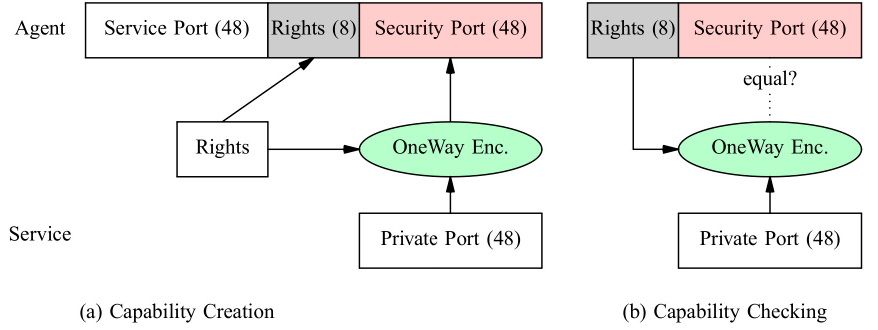
Figure 7. ( Top ) Capability format. ( a ) Capability creation by encoding private security port and new rights field. ( b ) Capability checking by encoding requested rights field and private security port and comparison with provided security port.